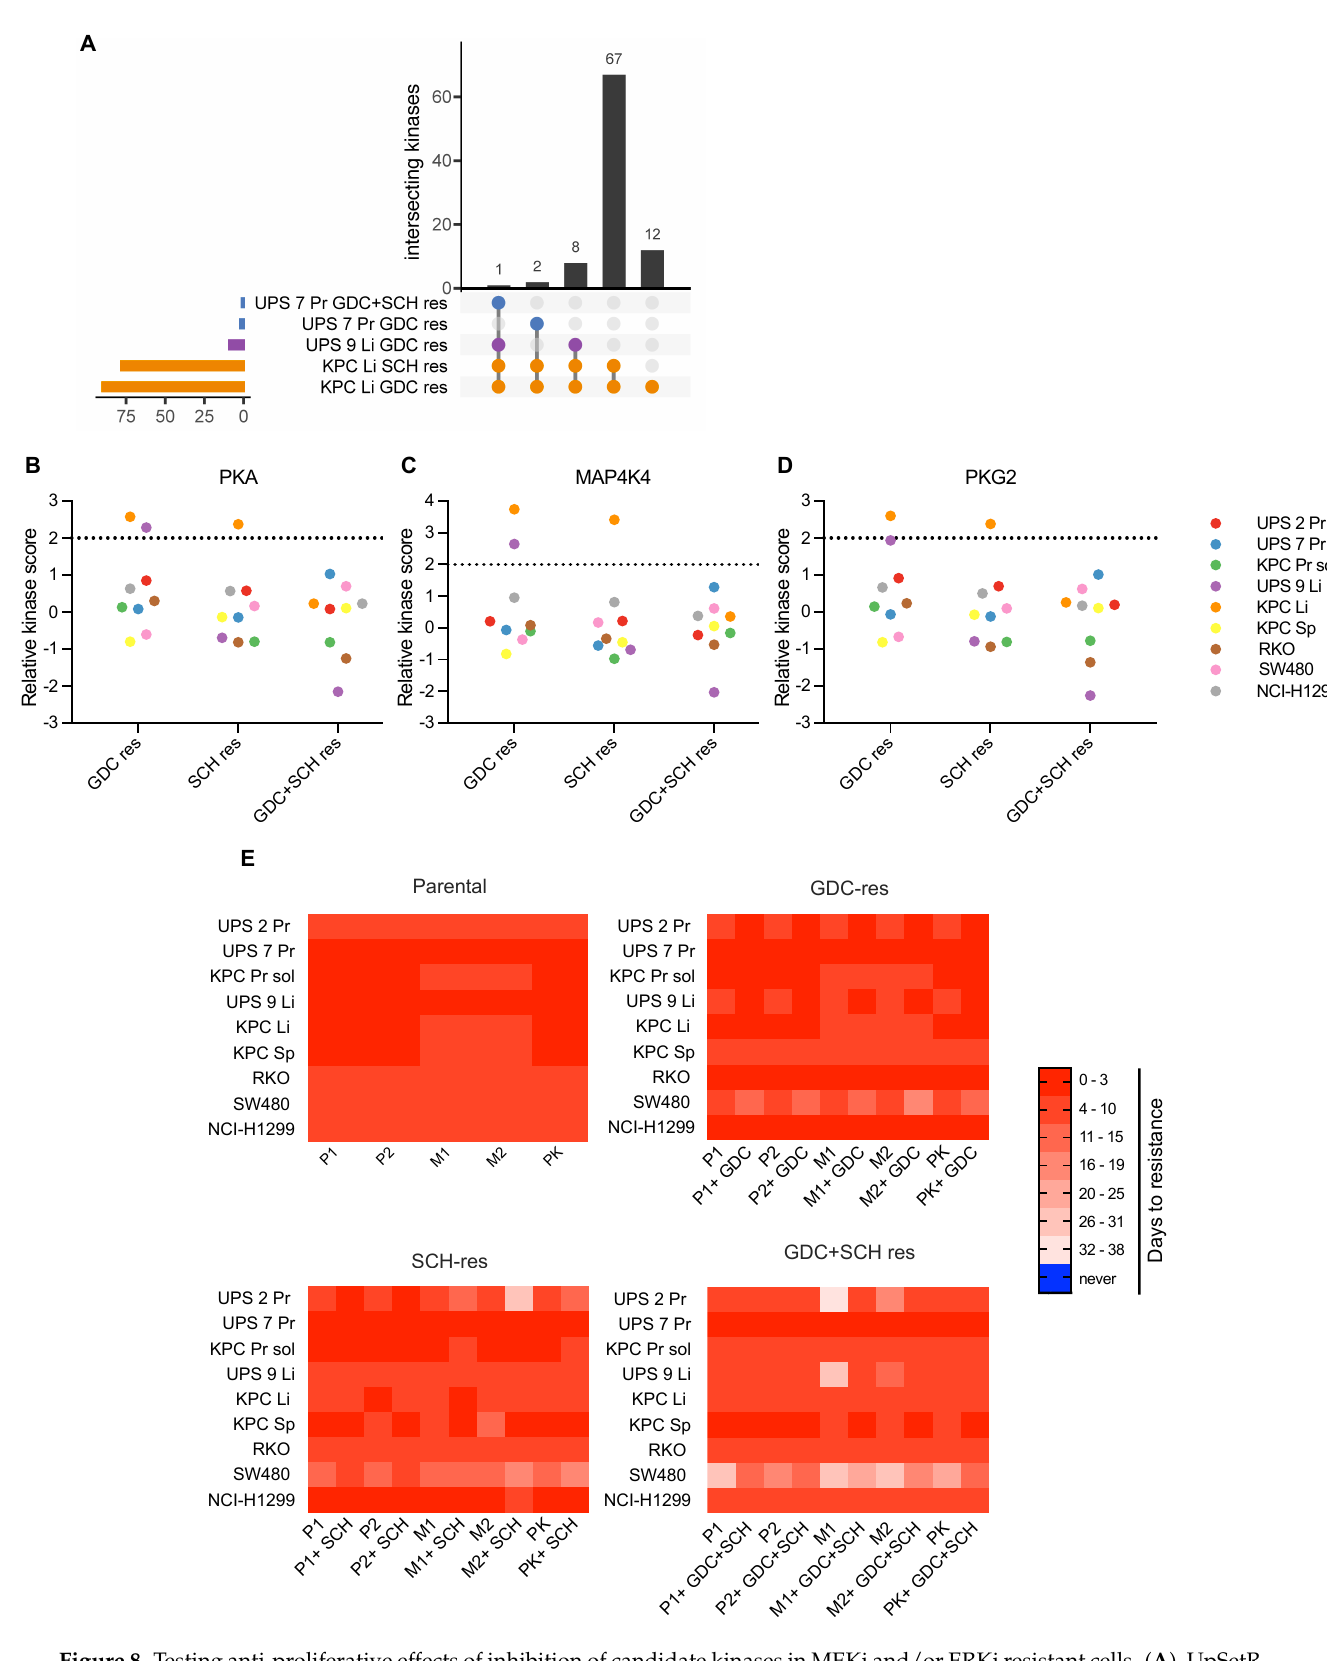
Figure 8. Testing anti-proliferative effects of inhibition of candidate kinases in MEKi and/or ERKi resistant cells. ( A ). UpSetR plot of the overlapping upregulated kinases with LFC mean kinase score greater than or equal to 1.5. The bar plot (top) shows the number of intersecting upregulated kinases among the sets of cell lines that are indicated in the matrix below. The bar plots on the left show the total number of upregulated kinases in each cell line. ( B – D ). Ratios of upstream